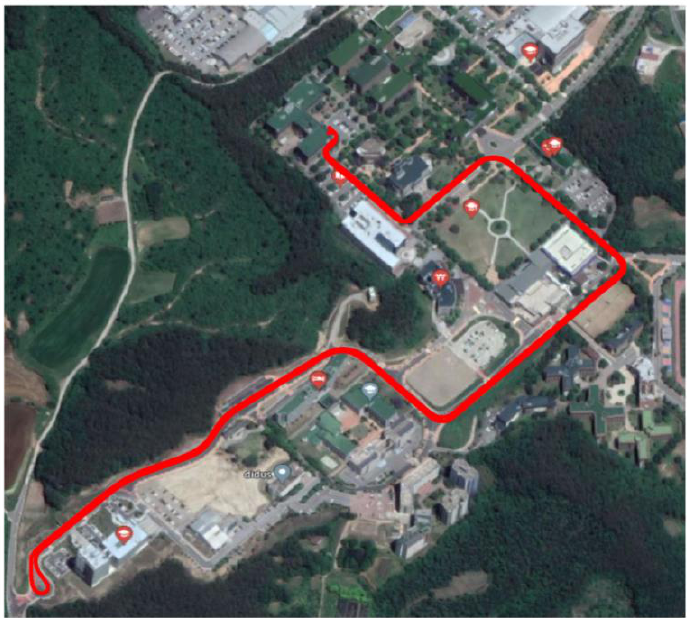
Figure 11. Test location for vehicle localization.